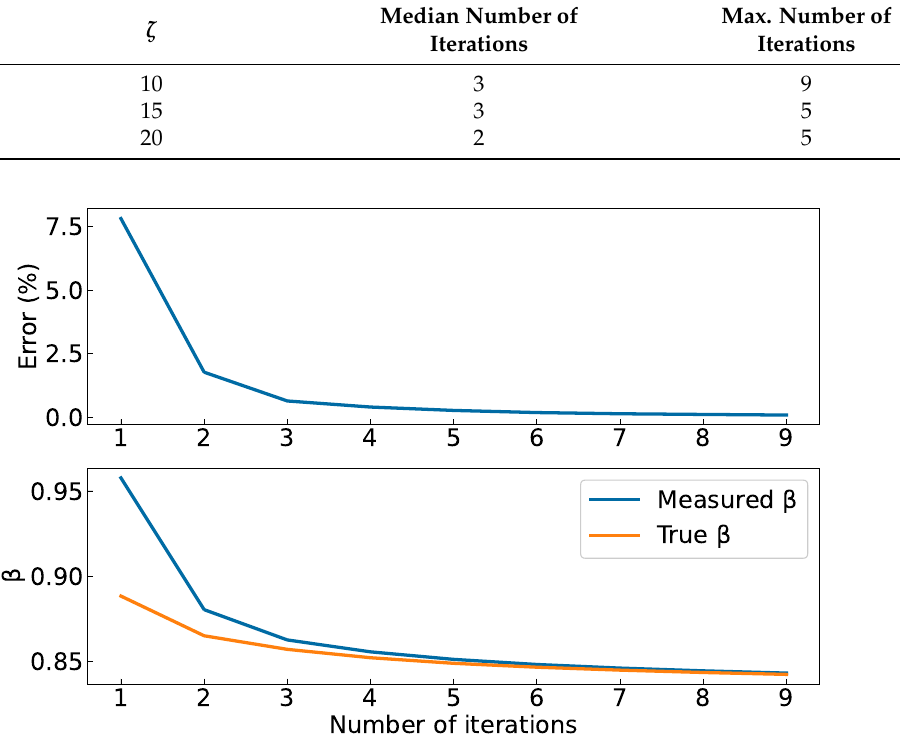
Figure 7. Variation of the ‘measured’ and ‘true’ β values during the iterative process (for the case that required the largest number of